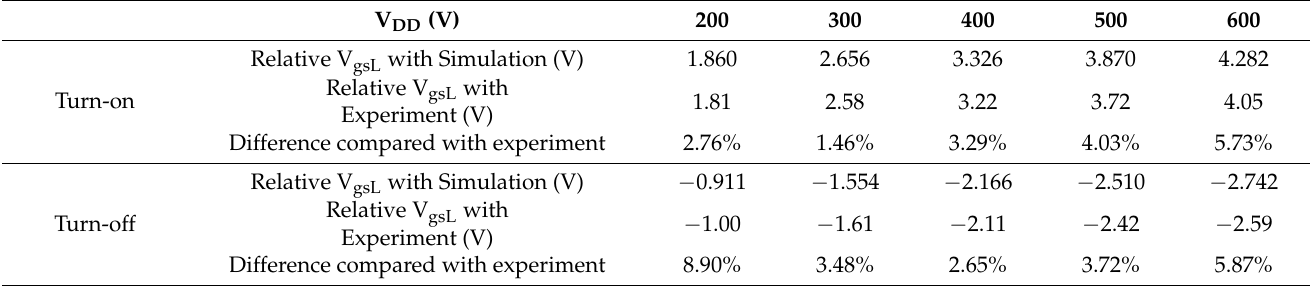
Figure 23. Comparison of simulation and experimental waveforms of crosstalk with different V DD . ( a ) and ( b ): simulation. ( c ) and ( d ): experiment. Left: turn-on. Right: turn-off. Table 6. Comparison of Experiments and Simulations with Variable V DD.